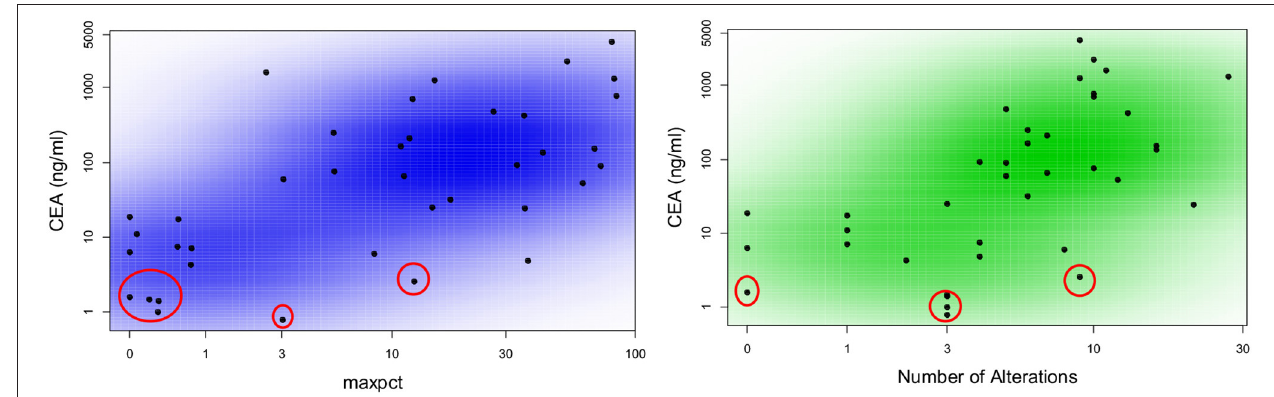
FIGURE 2 | Correlation between CEA as a marker of tumor burden and number of alterations or maximal allele frequency found in liquid biopsy from patients with metastatic colorectal cancer . Scatter plot colored by smoothed density demonstrating correlation between maxpct and number of alts with CEA. Plots include data from all available blood samples. There is a direct correlation between maxpct with CEA (Kendall’s Tau = 0.436; p = 0.001) and number of alts with CEA (Kendall’s Tau = 0.451; p < 0.001). The values circled in red represent three patients who never had elevated CEA despite high burden of metastatic disease. One of these patients had four serial liquid